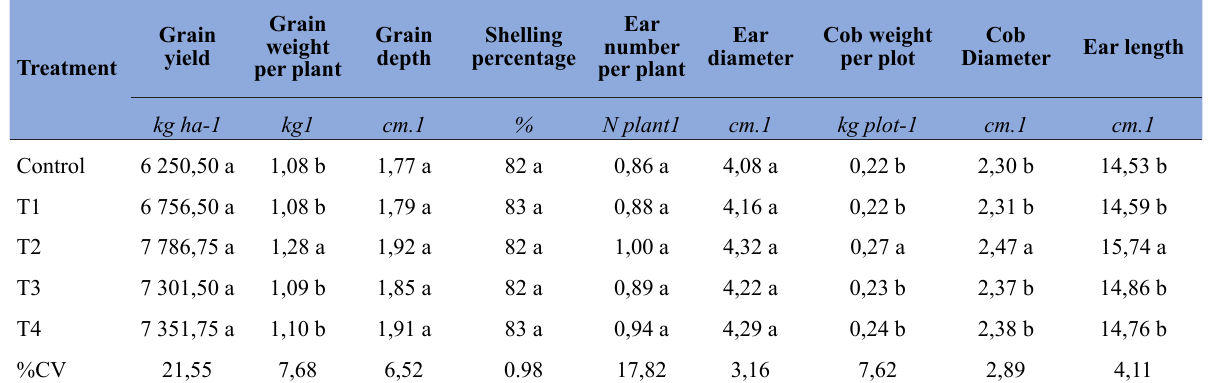
Table 3. Grain yield components and Azospirillum sp. inoculation in hybrid corn ‘Insignia 800’